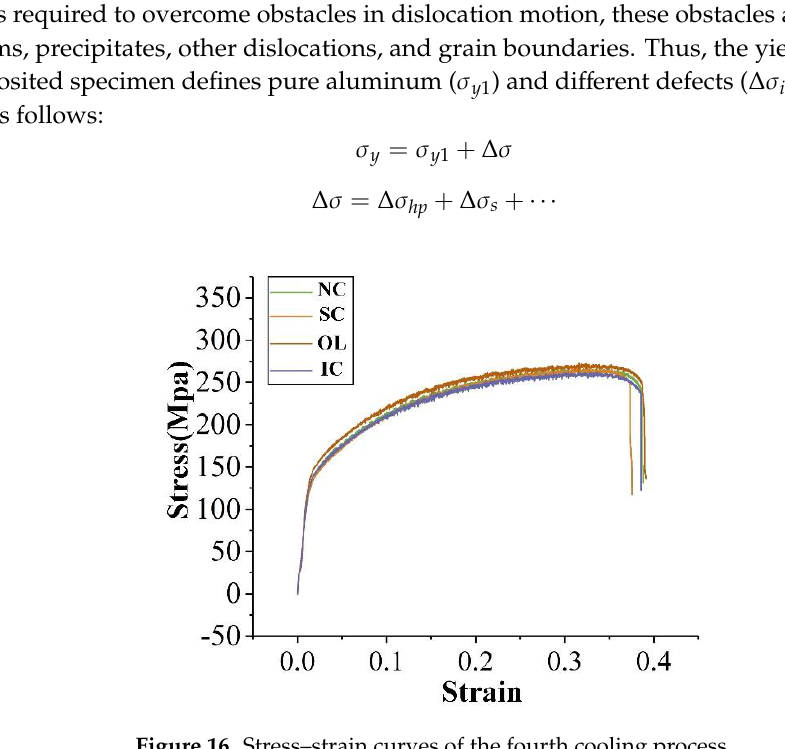
Figure 17. Yield strength (Mpa), tensile strength (Mpa), and elongation (%) of as-deposited specimens by different cooling processes. In this study, due to the significant effect of the fast cooling rate on grain size by the OL process, as shown in Figure 11, a large equiaxed grains area occurred. Thus, a small average grain size of the as-deposited specimen was present. The reduction in grain size increases the yield strength according to Hall–Petch relation, as follows: Δ𝜎 ℎ 𝑝 = 𝐾𝑑 −0.5 (3) where 𝑑 is the average grain diameter and 𝐾 is a constant [21]. Based on Equation (3), increasement of Δ𝜎 ℎ 𝑝 was predicted owing to the effects of grain refinement. Due to the high cooling rate produced by the OL process, as-deposited Al material in most cases does not contain coarse intermetallic particles. However, we found a small amount of Mg-rich precipitate in the specimens (Figure 13), although the volume fraction was slightly low. This was an indication that Mg mainly exists in the molten pool as a supersaturated molten solution, and the as- deposited specimens were not strengthened by the Orowan process. Mg atoms dissolved in the matrix Al form point defects that impede dislocation motion. Moreover, Mg atoms diffuse near the